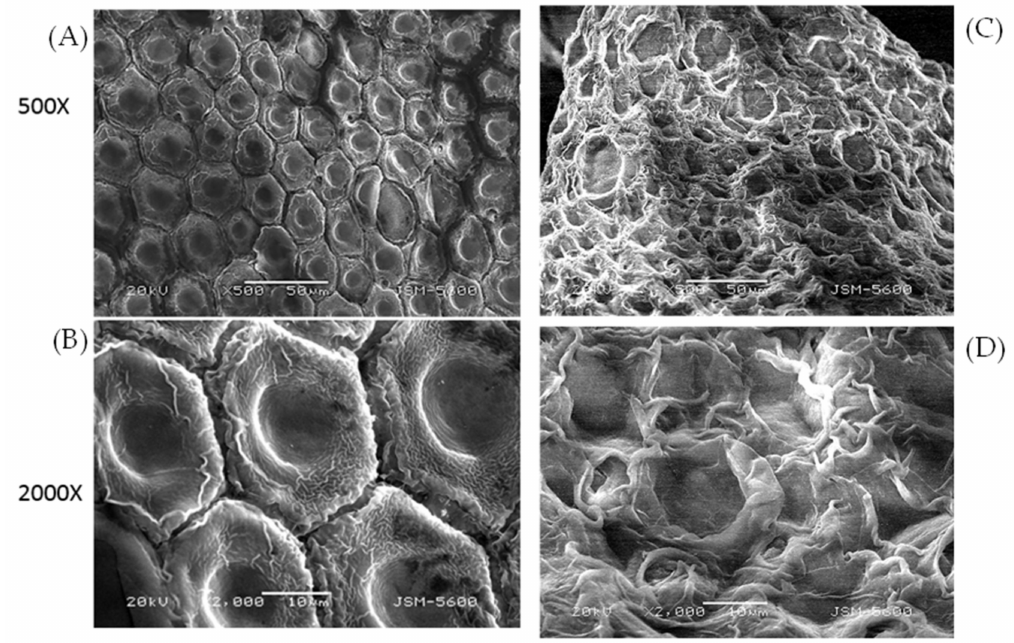
Figure 3. Scanning electron microscope of chitin and chitosan extracted from BSF pupal shell. ( A ) Chitin 500 × ; ( B ) Chitin 2000 × ; ( C ) Chitosan 500 × ; ( D ) Chitosan 2000 ×